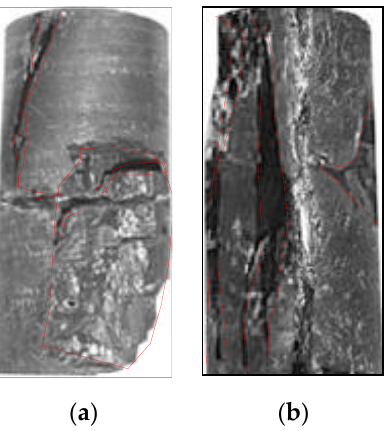
Figure 15. Damage patterns of the consolidated coal specimens. ( a ) Horizontal consolidation and ( b ) vertical consolidation.